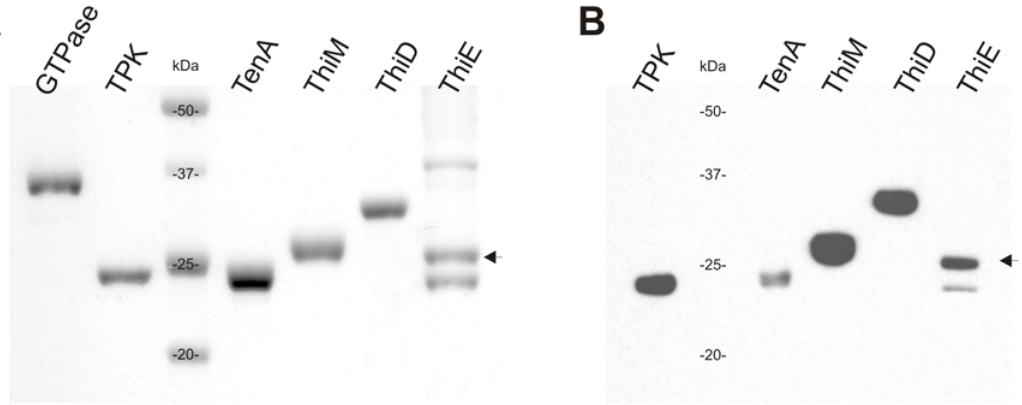
Figure 2. SDS-PAGE- and western blot-analysis of the recombinant enzymes of the S.aureus vitamin B1 metabolism. (A) SDS-PAGE of the affinity chromatography purified recombinant enzymes and (B) corresponding western blot analysis using a monoclonal anti-Strep antibody at a dilution of 1:5,000 according to material and methods. GTPase; TPK, thiamine pyrophosphokinase; TenA, thiaminase II; ThiM, THZ kinase; ThiD, HMP kinase; ThiE, TMP synthase. The arrow indicates the Sa ThiE protein.